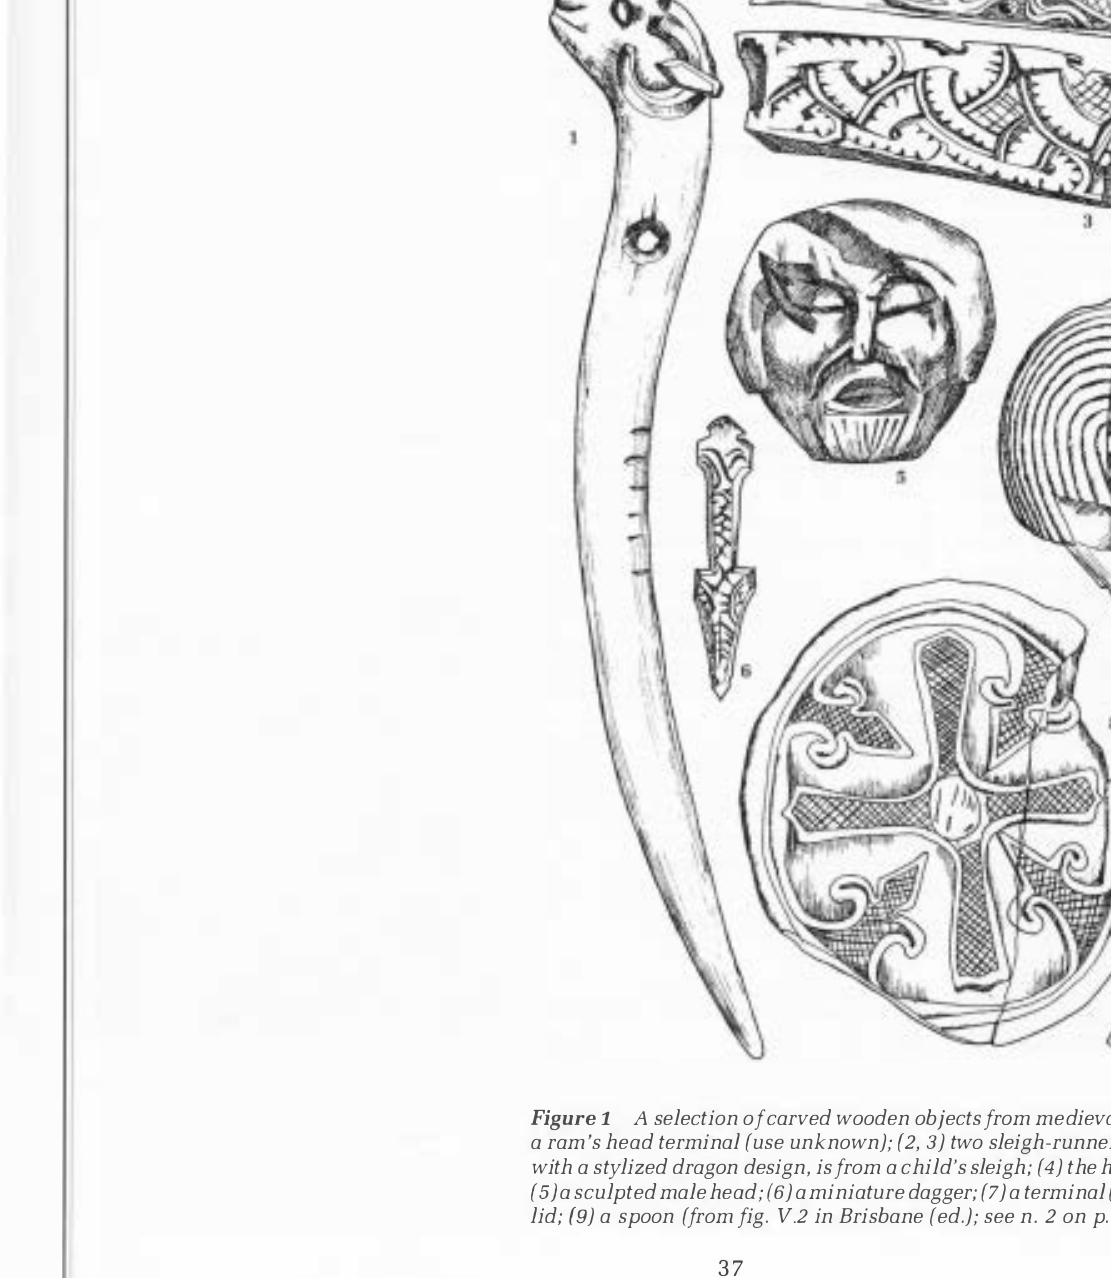
Figure 1 A selection of carved wooden objects from medieval Novgorod: a ram's head terminal (use unknown); {2, 3) two sleigh-runner supports; the longer one, with a stylized dragon design, is from a child's sleigh; ( 4) the handle of a scoop or kovsh; (5) a sculpted male head;{6) a miniature dagger; (7)a terminal (use unknown); (B)a vessel lid; {9) a spoon (from fig. V.2 in Brisbane (ed.); seen. 2 on p.